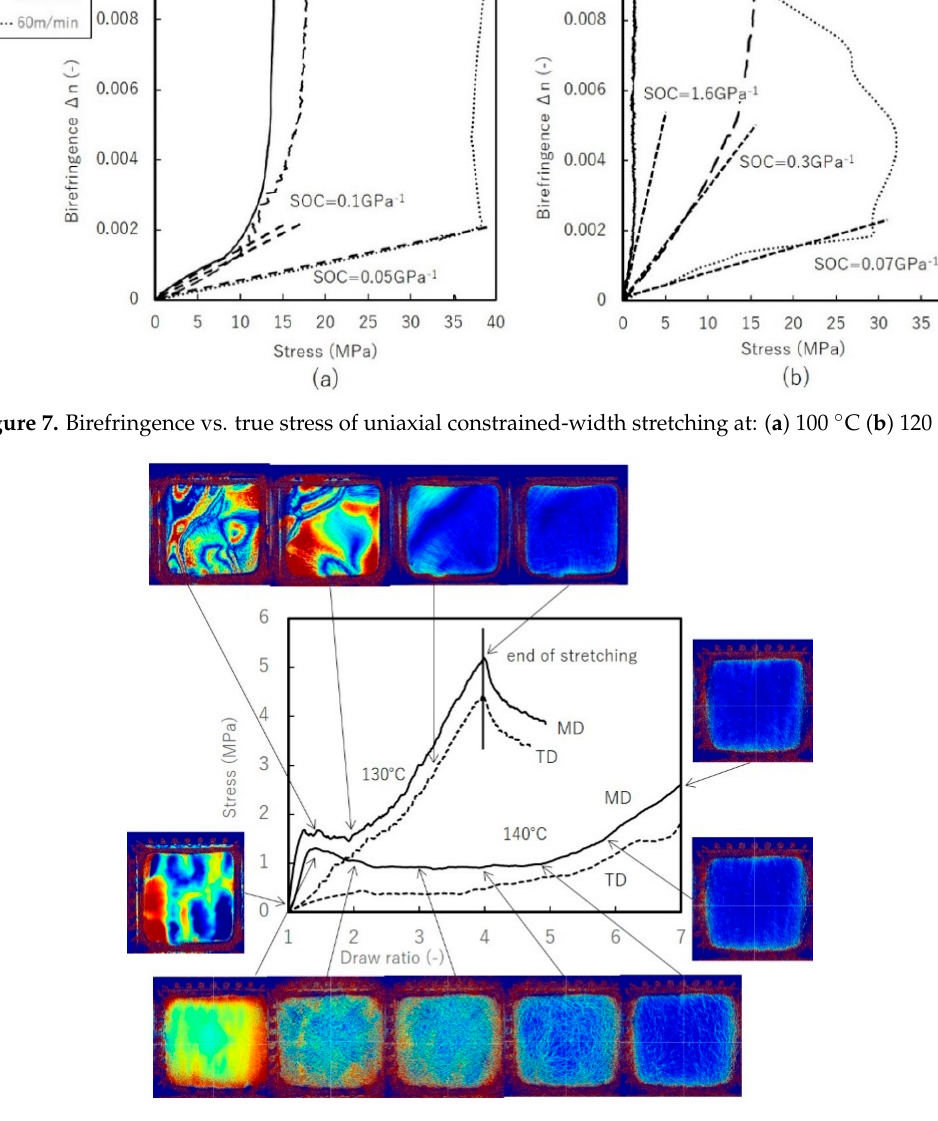
Figure 8. Stress vs. draw ratio of simultaneous biaxially stretched films at 130 °C and 140 °C with stretching speed of 1 m/min.